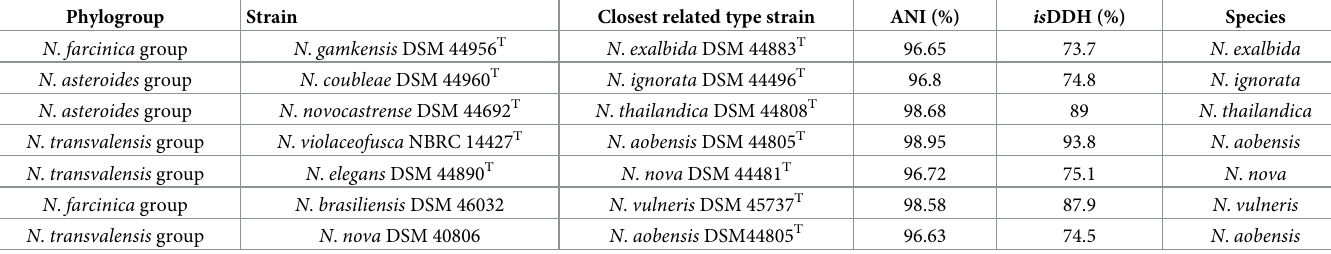
Table 1. Inconsistent species assignment of strains in the genus Nocardia . Phylogroup